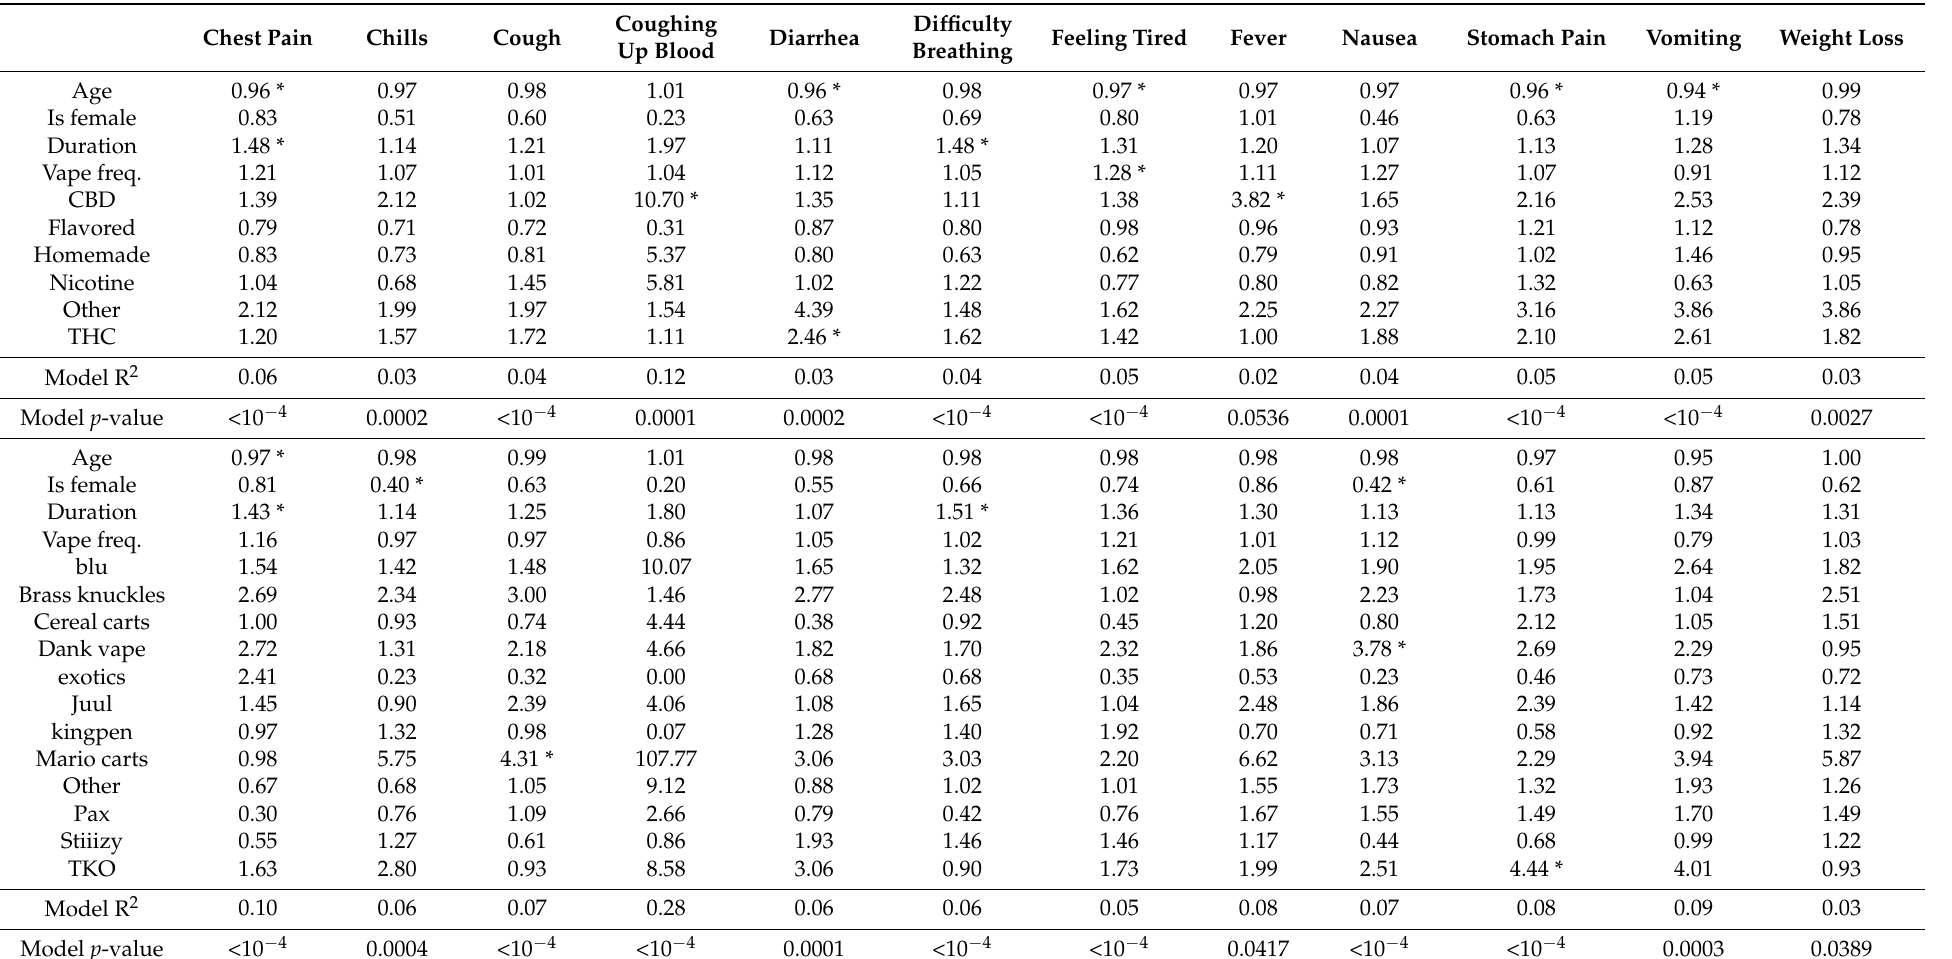
Table 2. Logistic regression model coefficients for ingredients (top) and products (bottom). Stars denote statistically significant results ( p < 0.05, with Bonferroni correction for each part of the table separately). Duration refers to the reported duration of